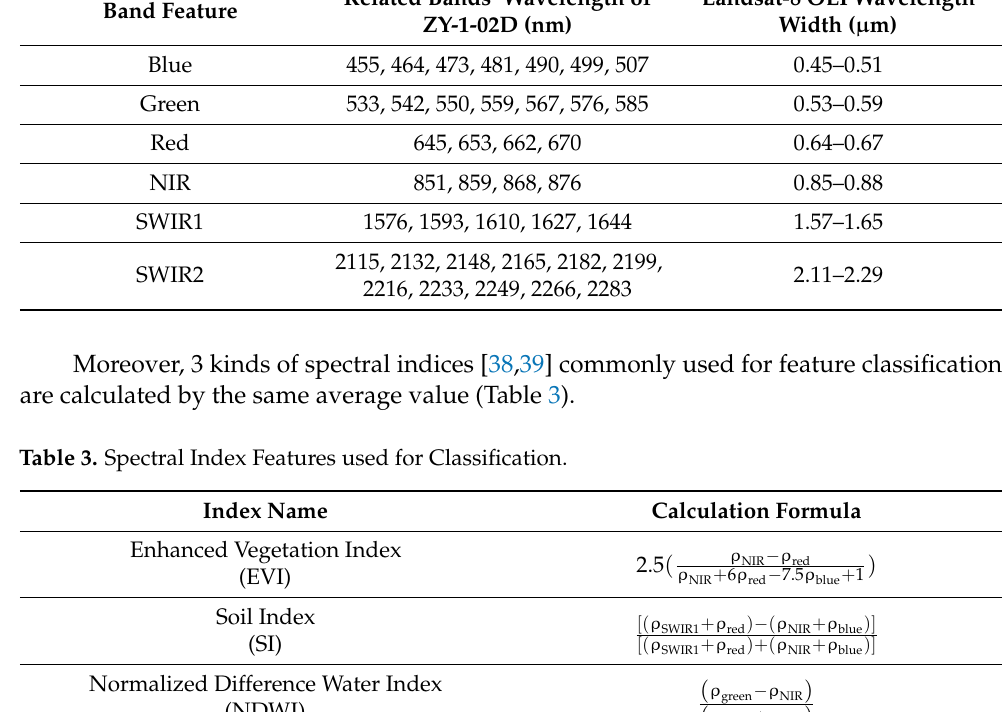
Table 2. Band features of ZY-1-02D reference to Landsat-8 Operational Land Imager (OLI).